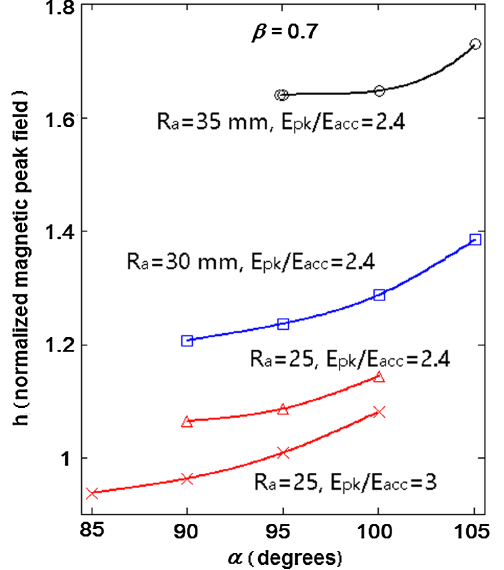
FIG. 22. Normalized magnetic peak field for different angles of the wall slope for β ¼ 0 . 6 . Points a, b, and c are shown for comparison with data from [16], see text.